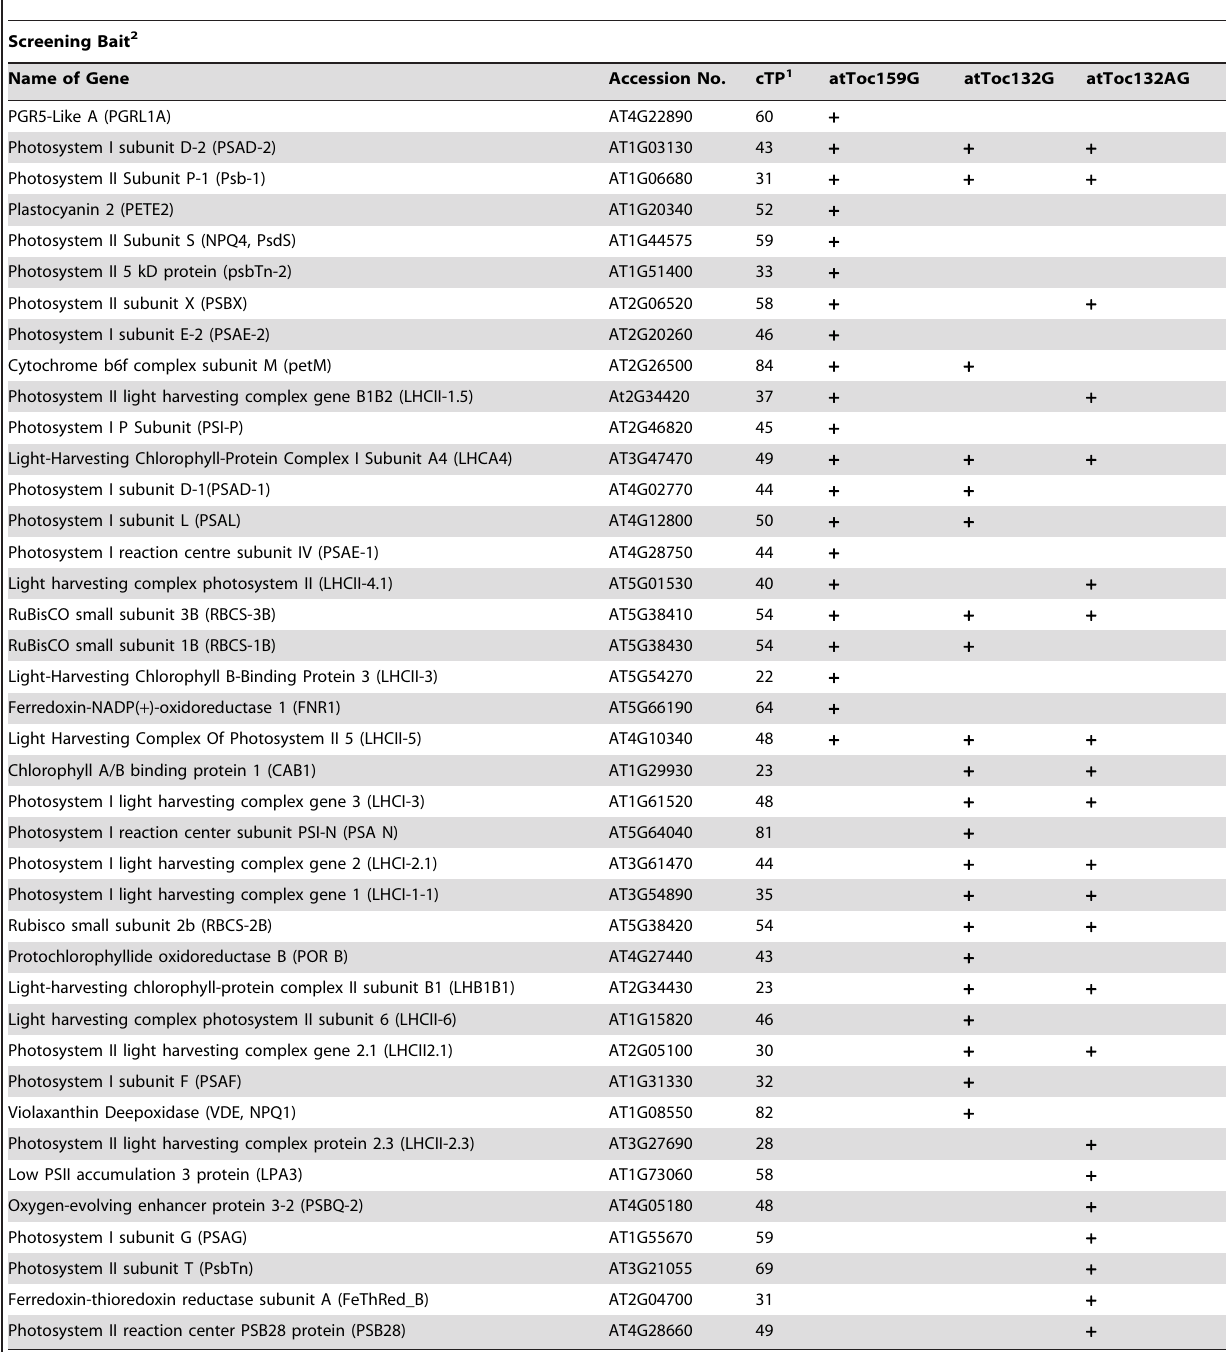
Table 2. List of plastid proteins with a photosynthetic function identified as interactors with atToc159G-, atToc132G- and atToc132AG-domain bait proteins in the split-ubiquitin yeast two-hybrid screen.